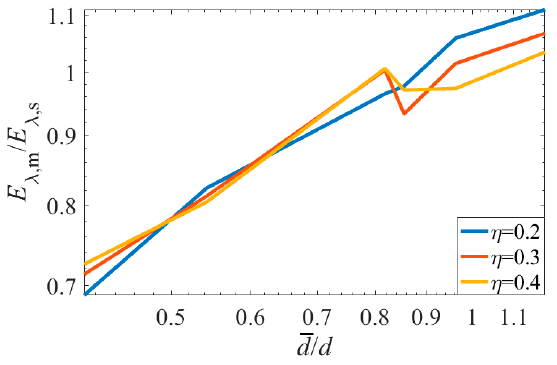
η ( ) E d λ and d under different total compression ratios. and under different total compression d E λ ,s ( η ) η d ( ) E λ ,s